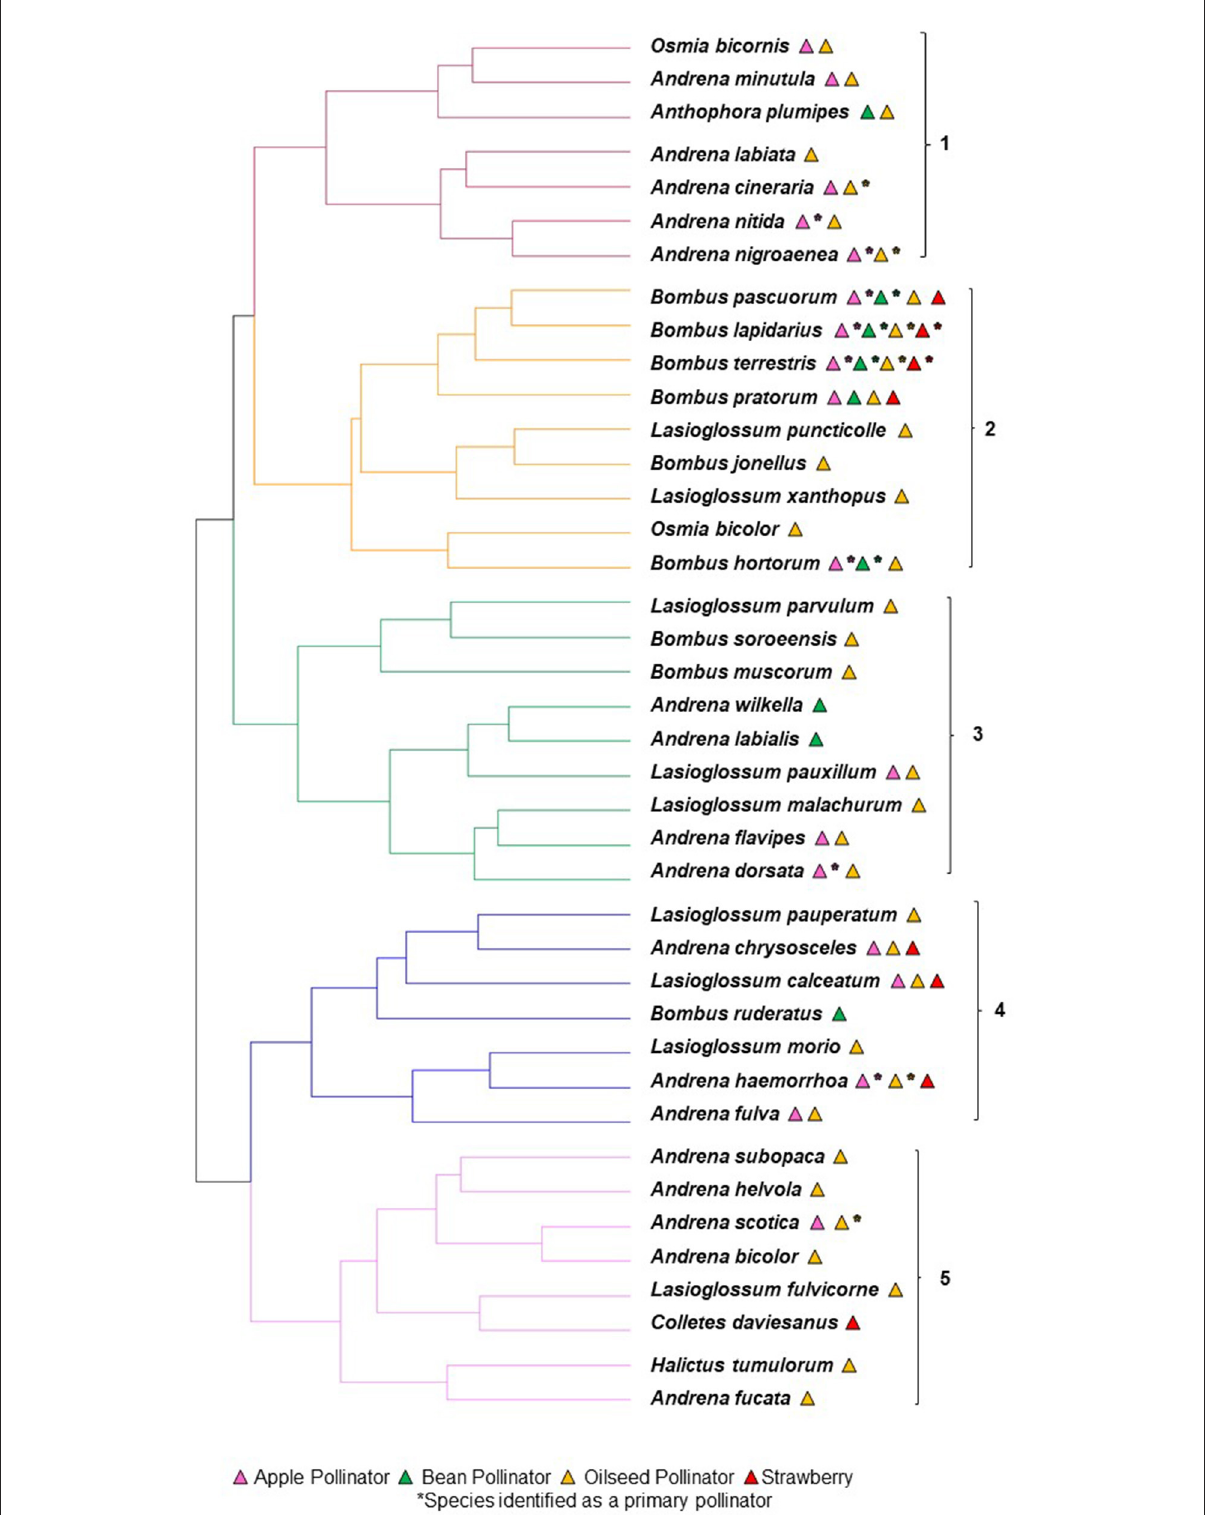
FIGURE1 Dendrogram showing the hierarchical relationships amongst five clusters of bee crop pollinators for apple (18 spp.), bean (9 spp.), oilseed (36 spp.) and strawberry (8 spp.) Individual clusters are colored for clarity. Species with more correlated occupancy dynamics join further to the right-hand side of the dendrogram. Triangles with an asterisk to the right-hand side denotes species identified as primary pollinators of that